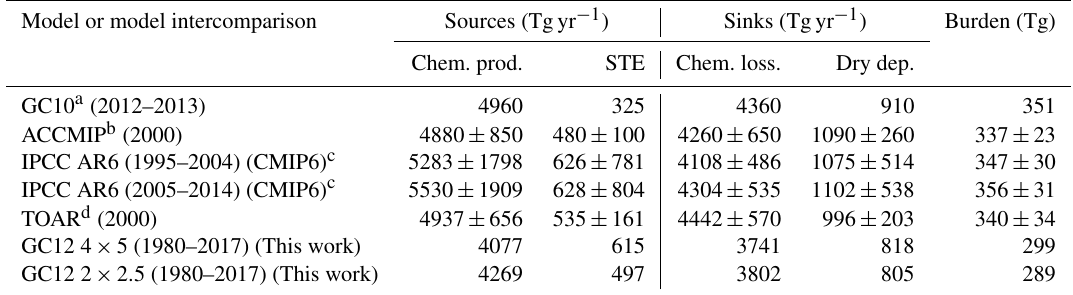
Table 4. Ozone budget terms in various model studies, with target years of simulations identified in the first column of the table. The standard deviations describe the spread among models in the model